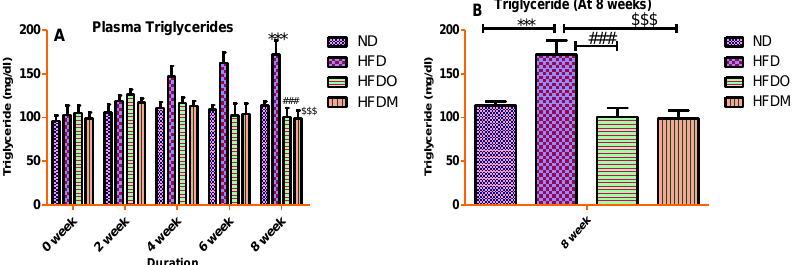
Figure 9. Treatment with MESK reduced the high-fat diet-induced hypertriglyceridemia in the diet- induced obese mouse model. ( A ) Change in the plasma triglycerides during the study period and ( B ) change in triglyceride level after the eighth week. (N = 5, *** p < 0.001 between ND and HFD, ### p < 0.001 between HFD and HFDO, $$$ p < 0.001 between HFD and HFDM). (ND: normal diet, HFD: high-fat diet, HFDO: HFD + Orlistat, HFDM: HFD + MESK).